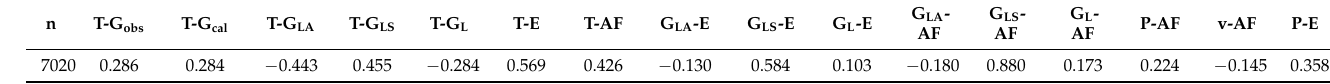
Table 5. Correlations among monthly solar radiation (observed and calculated, G obs and G cal , losses caused by absorbing and scattering GLPs and total loss, G LA , G LS , and G L ) and meteorological parameters (air temperature T, relative humidity RH, water-vapor pressure E, air pressure P, and wind speed v, S/G, in January 2008–December 2011 (model development, n =